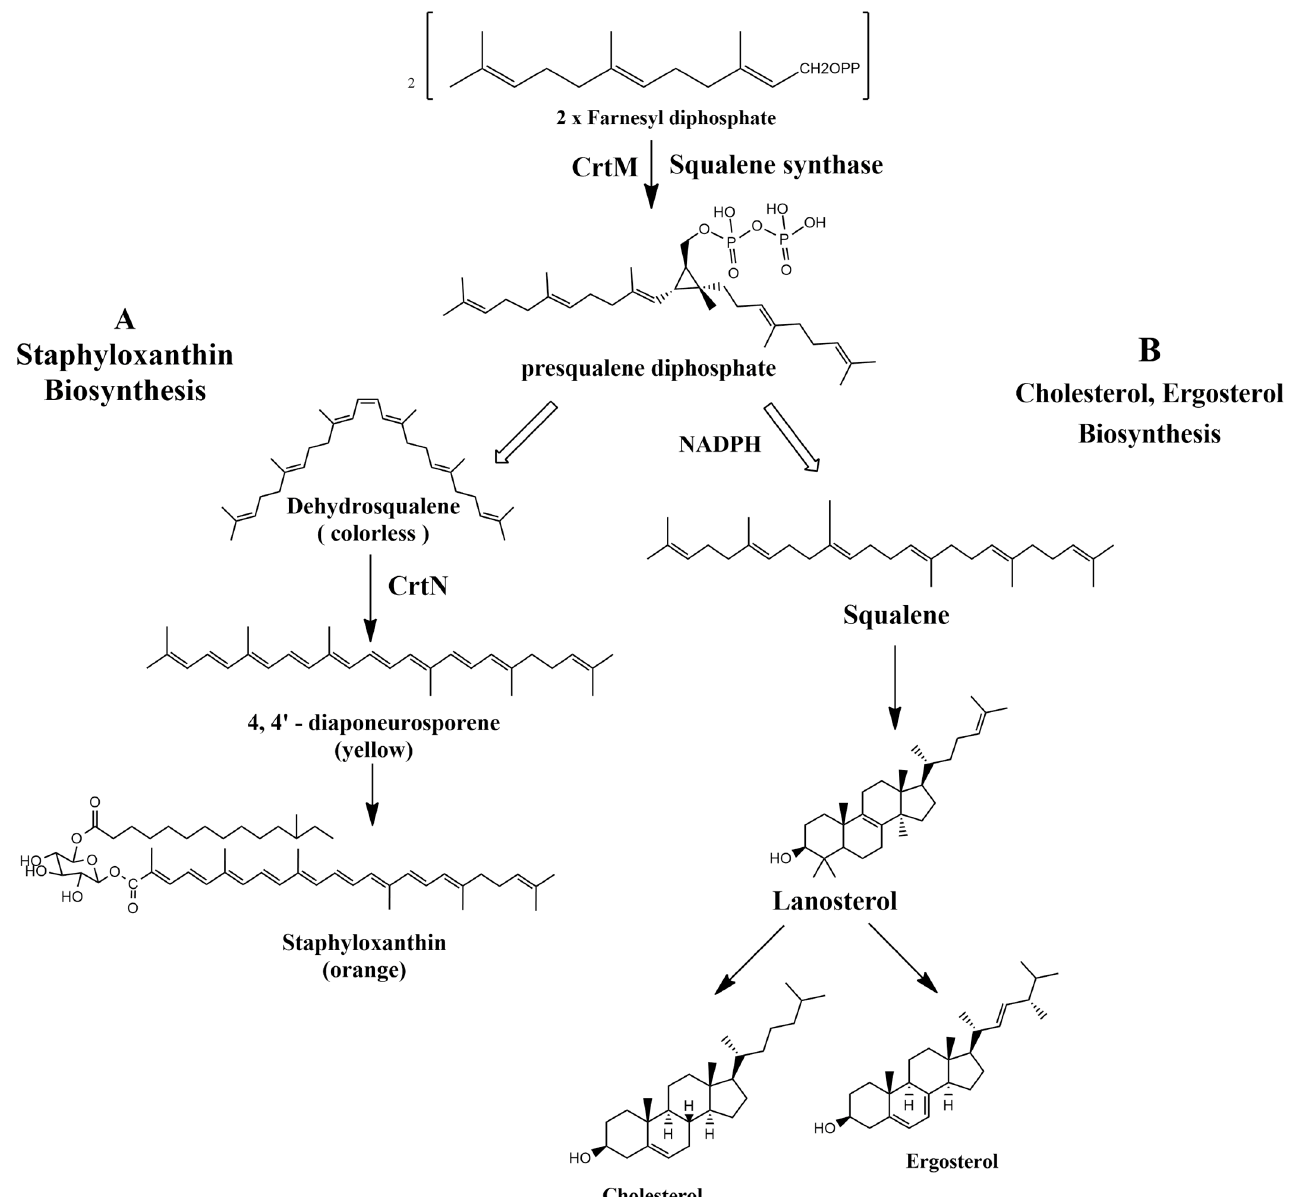
Figure 1. ( A ) Staphyloxanthin biosynthesis pathway in S. aureus . ( B ) Cholesterol and ergosterol biosynthesis pathway.